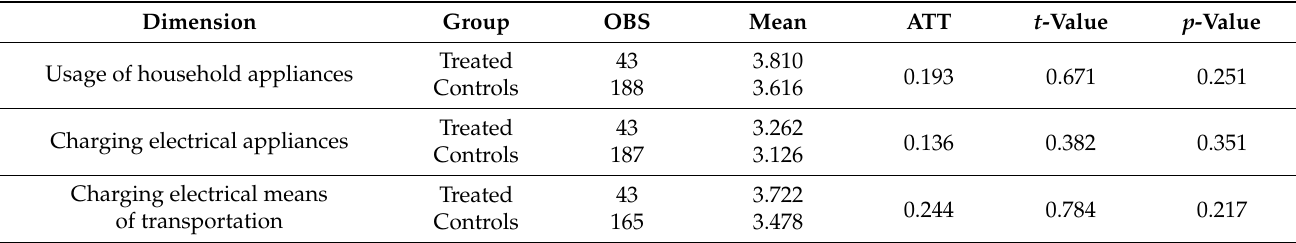
Table 9. Demand flexibility comparisons of Solar-sellers (treated) versus Non-owners (controls) (source: authors’ own calculations).